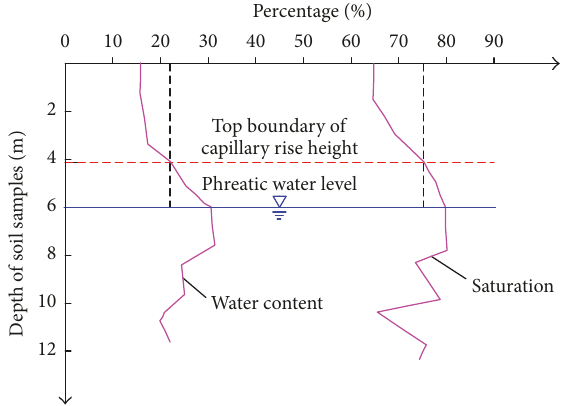
Figure 4: Soil moisture content and saturation ratio versus soil sample depth.